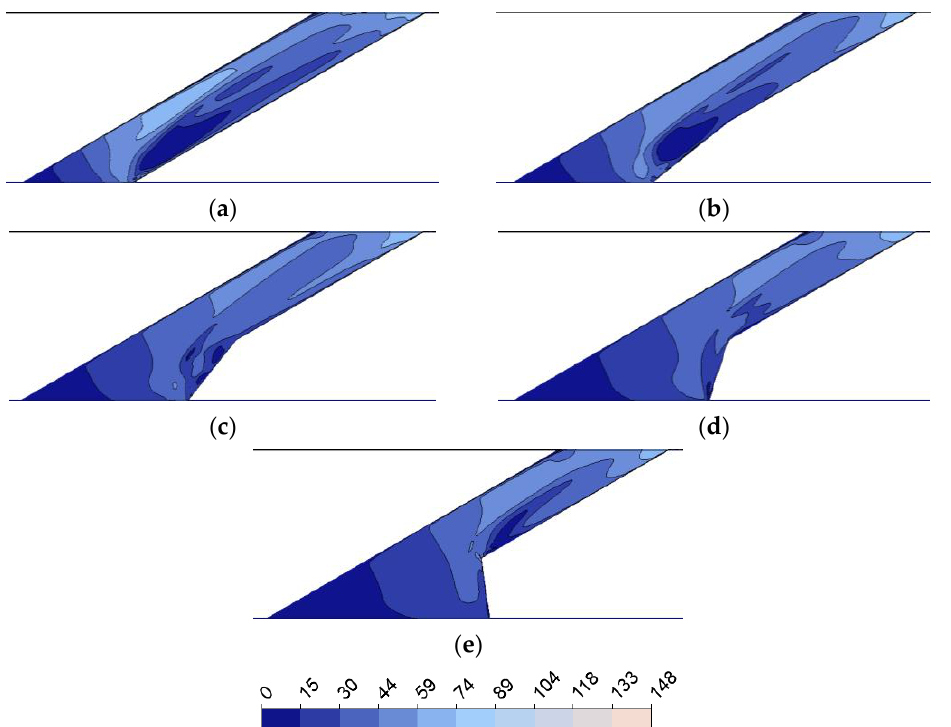
Figure 9. 𝜂 𝑠 with expansion behind the inlet hole.